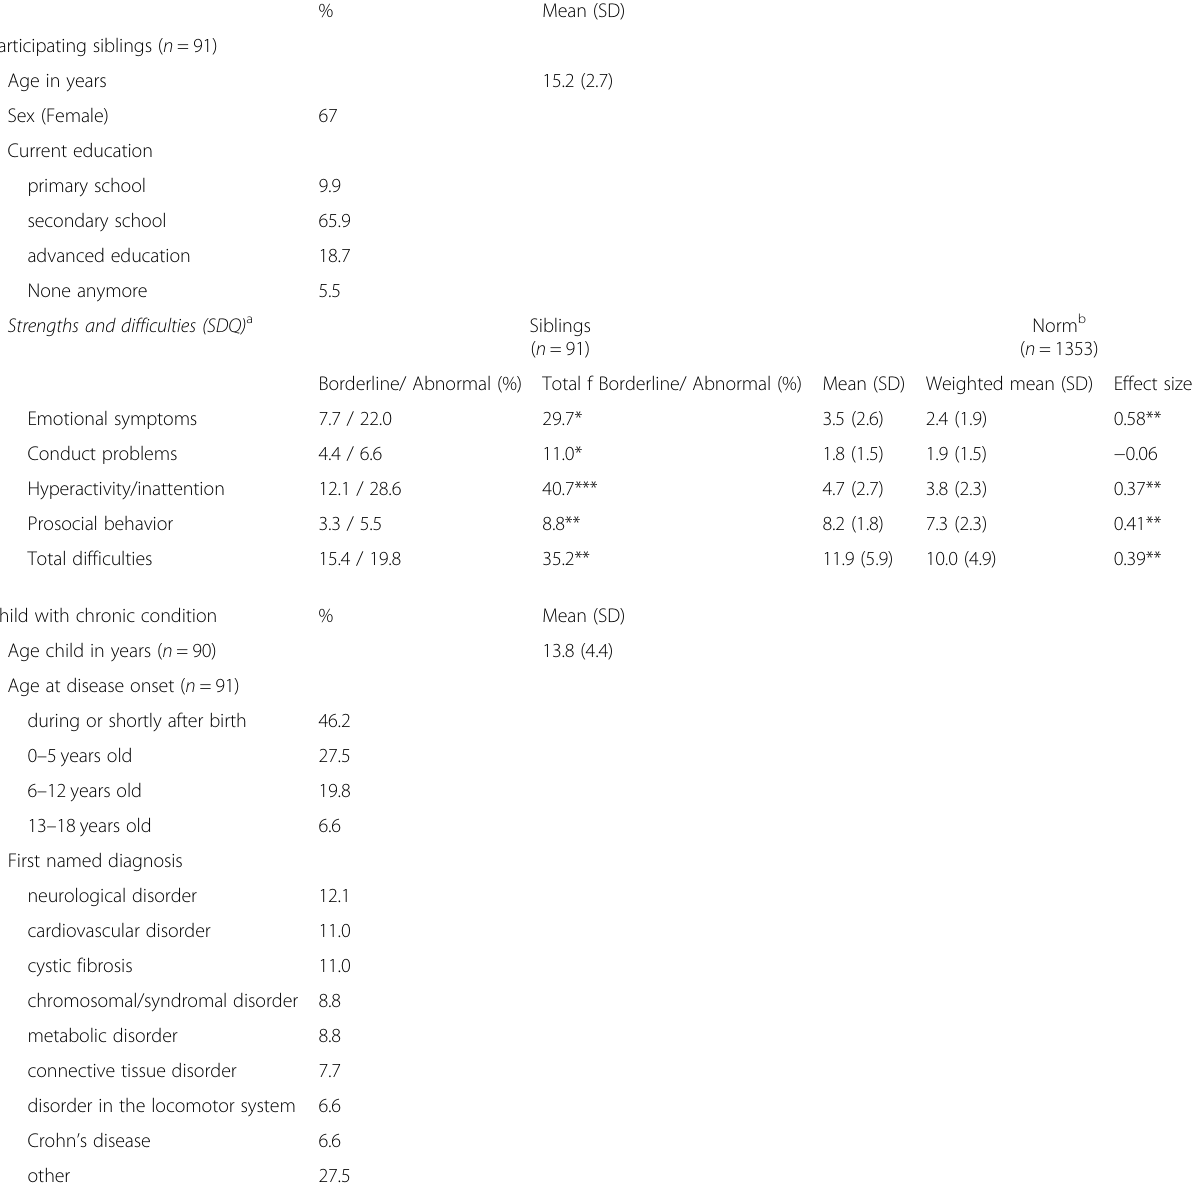
Table 1 Background